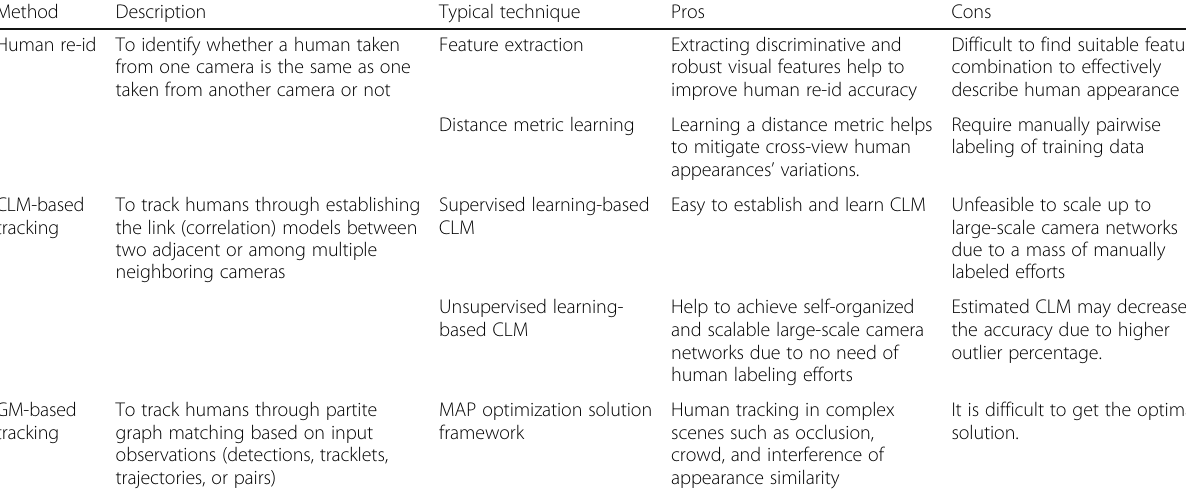
Table 4 Human tracking algorithms across non-overlapping cameras Method